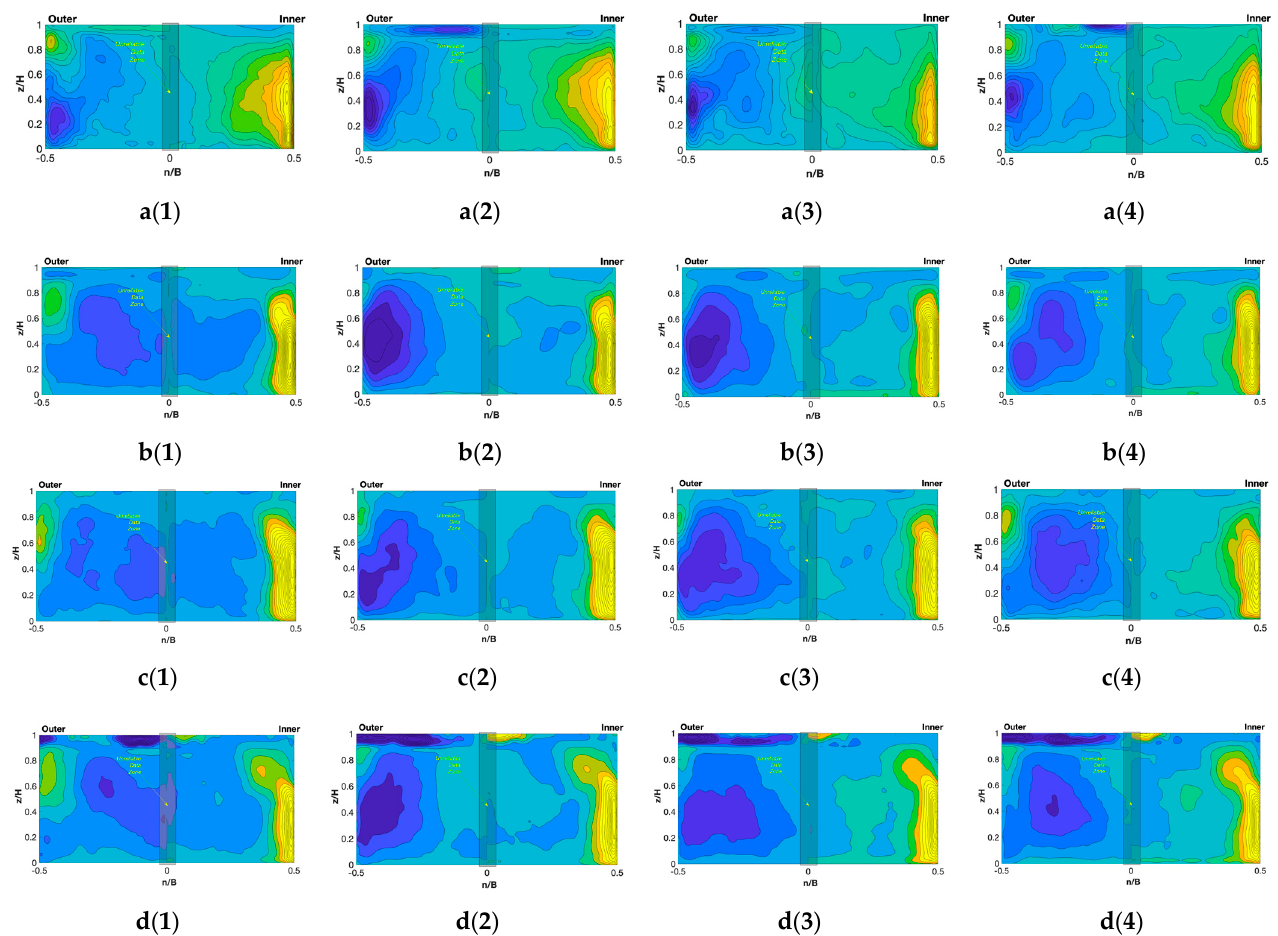
Figure 8. Dimensionless vertical velocity distribution at ( a ) 37 degrees; ( b ) 90 degrees; ( c ) 105 degrees; ( d ) 125 degrees. The numbers 1, 2, 3, and 4 denote different jet conditions (1) no jet; (2) S = 3.5; (3) S = 10; (4) S = 16.5.